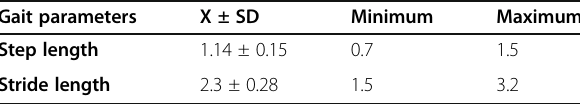
Table 2 Descriptive characteristics of the gait parameters of